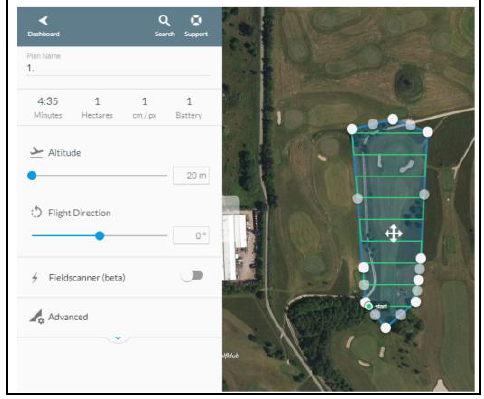
Figure 3. Pre-planned flying